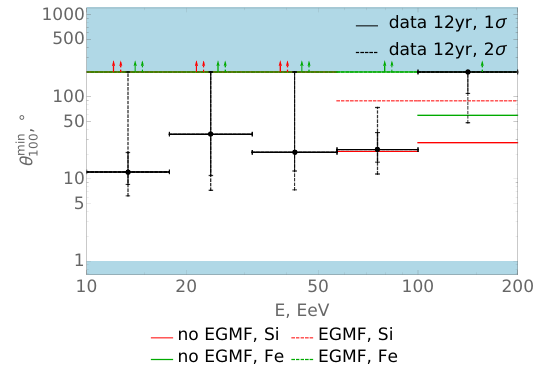
Figure 6. Comparison of the model predictions in the case of pure heavy composition (Si, Fe) with the data, with zero and with maximum